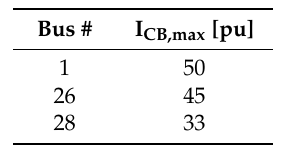
Table 5. Circuit breaker limits in Case